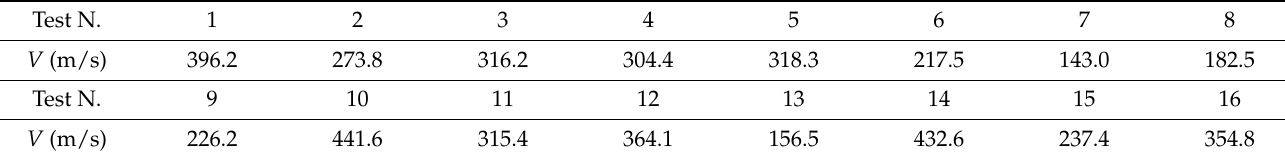
Table 4. Results of water velocity in each test.